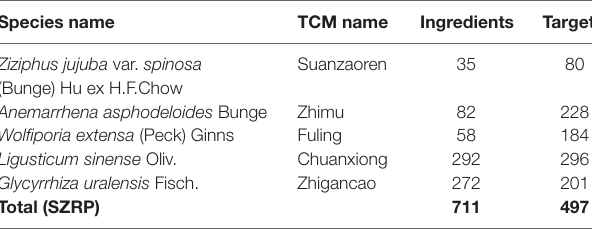
TABLE 1 | Number of ingredients and known targets for each herb in